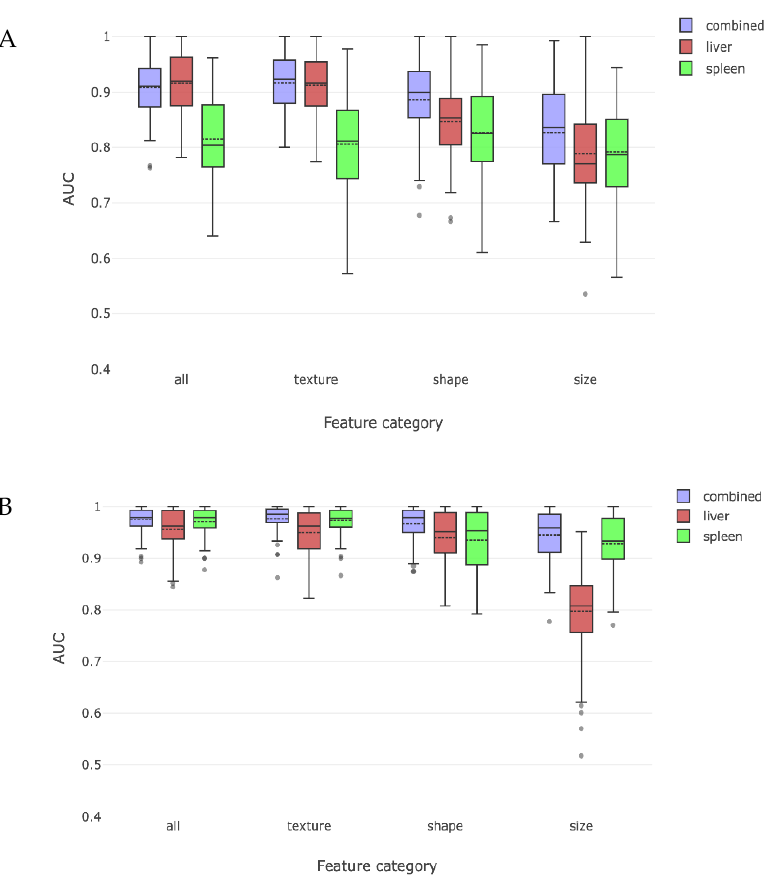
Figure 5. This figure charts radiomic discrimination of cirrhosis between non-cirrhosis cohort and either low MELD ( A ) or high MELD ( B ) cirrhosis sub-cohorts. Results are similar to, but somewhat less effective than, the compensation/decompensation sub-cohort experiments. This difference may be because the MELD score does not in itself predict cirrhosis with absolute accuracy.